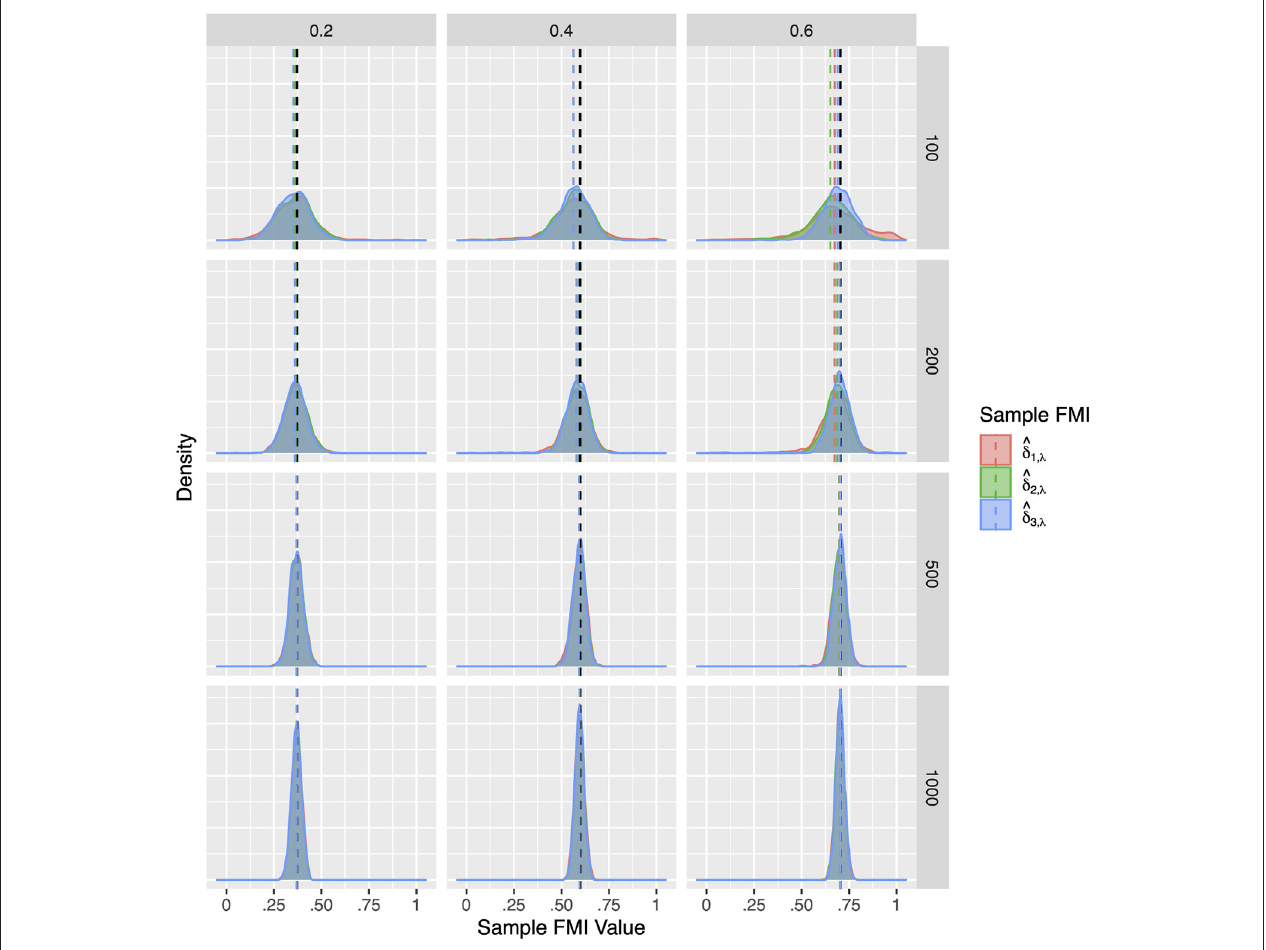
FIGURE 8 | The sampling distribution of FMI for factor loadings in linear MAR. The panel rows correspond to sample sizes of N columns correspond to per variable missing rates of 20, 40, and 60%, or overall population missing rates of 10, 20, and 30%. The population FMI value in each panel is given as a vertical black dotted